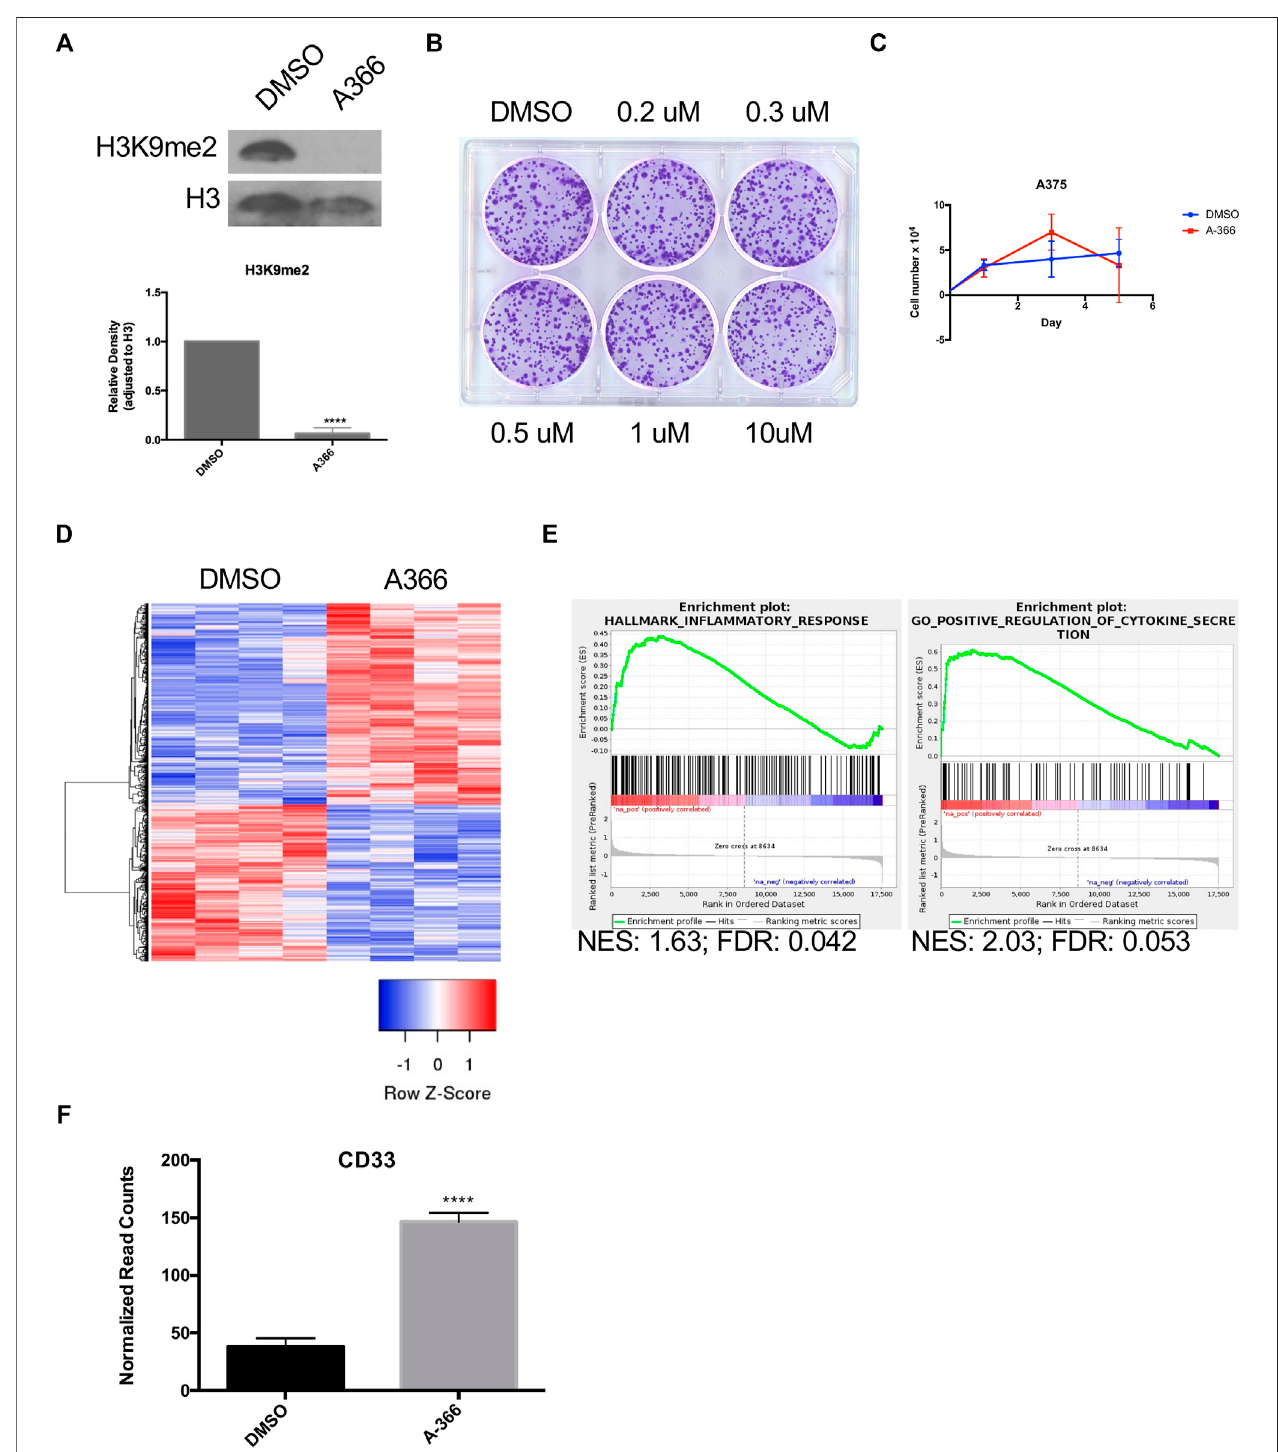
FIGURE 3 | A-366 induces in fl ammatory response with no effect on cellular growth. (A) Western blot of acid-extracted histones from A375 cells incubated with either DMSO or 0.2 µM A-366 for 48 h. Densitometry analysis from four independent experiments. (B) A375 cells were treated with the indicated concentrations of A- 366for10 daysandassessedforcolonyformation. (C) CellgrowthanalysisofA375cellstreatedwithDMSOorA-366( n =3). (D) Top100differentiallyexpressedgenes betweenDMSOandA-366 treatedcells(sortedby p -valueadjusted). (E) GSEAplotshowingenrichmentinA-366treatedcells. (F) RNAseqnormalizedcounts for CD33 in sorted cells ( n = 4). ( p < 0.0001).